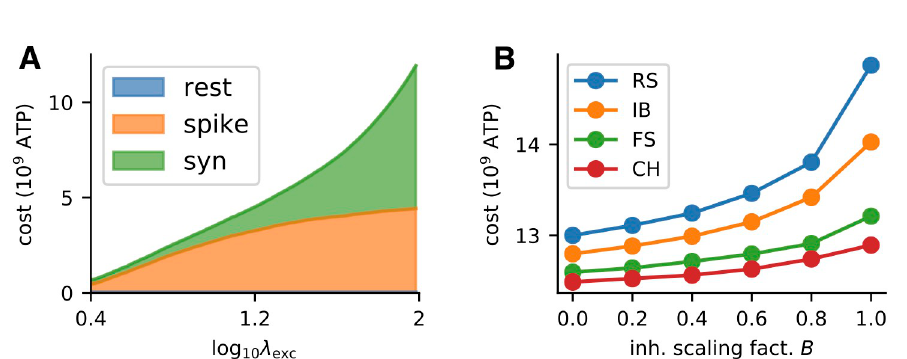
Fig 5. Metabolic cost of neural activity. (A) Cost of response for a given input x = λ exc , RS neuron (Tab A in S1 Appendix), Δ = 100 ms, B = 0.4. (B) Cost of maintaining a firing rate of 12 Hz for 100 ms for different values of inhibition to excitation